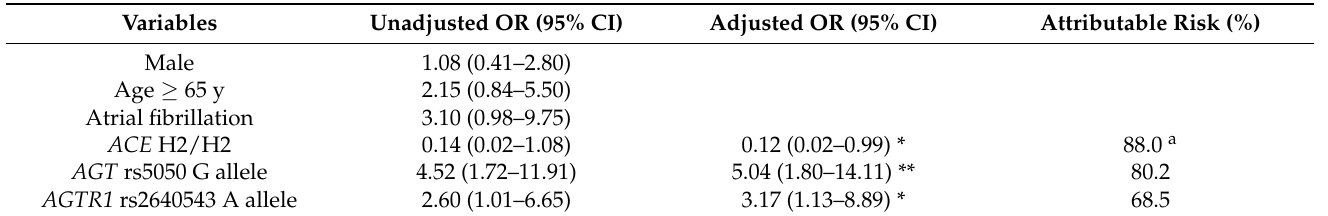
Table 3. Multivariable analysis to identify predictors for bleeding complications at therapeutic INR.